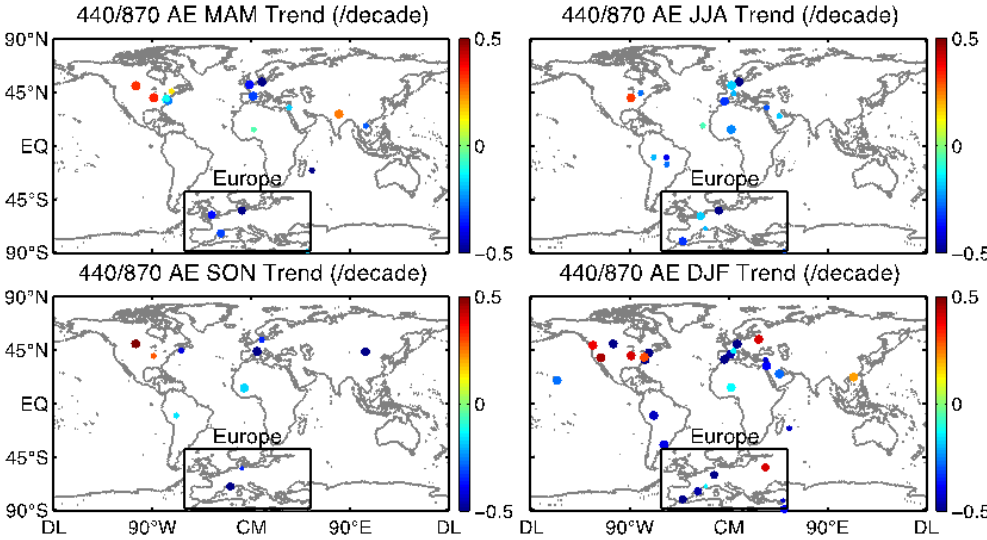
Figure 7. Seasonal trend for the